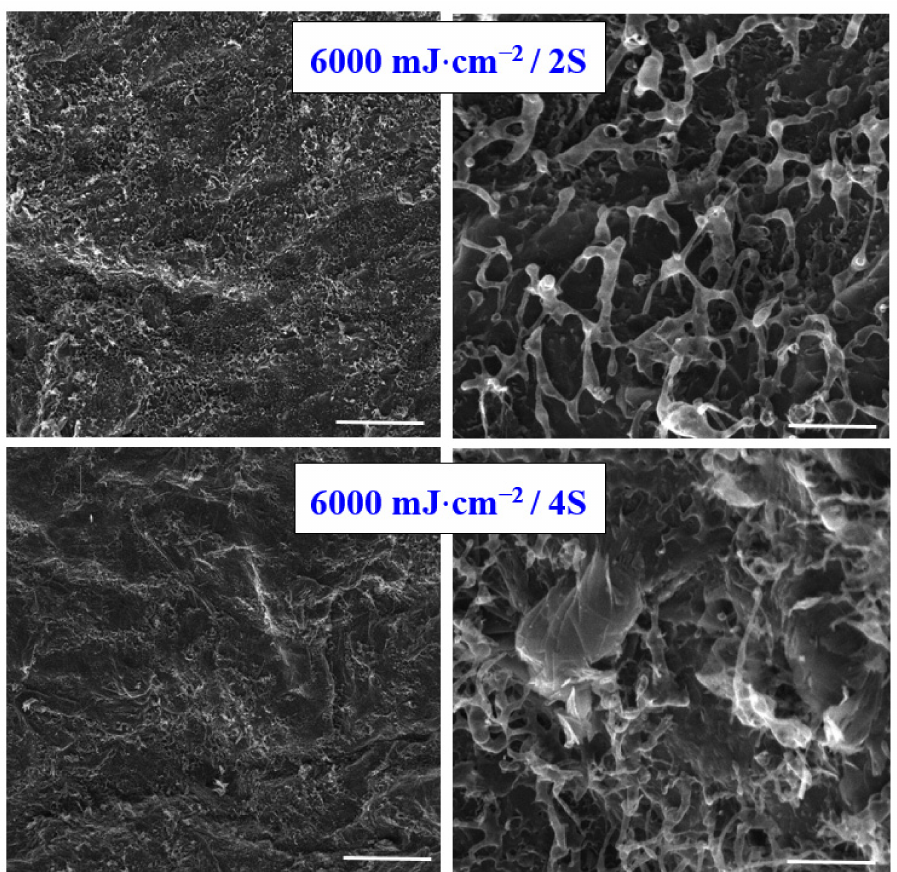
Figure 5. Scanning electron microscopy images of carbon sheet exposed with high energy excimer laser and laser fluence 6000 mJ · cm − 2 , two (2S) and four shots (4S) were applied. The scanning areas were 100 × 100 µ m 2 ( left column) and 10 × 10 µ m 2 ( right column). White lines represent 20 microns ( left ) and 2 microns ( right